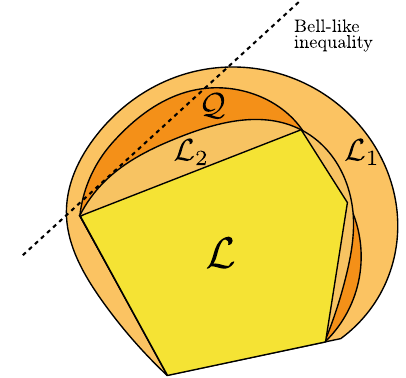
FIG. 1. Pictorial representation of the sets of correlations, together with our approach to detection of multipartite non- locality. The L and Q sets delimit the local and quantum correlations, respectively. As shown here, the first forms a polytope, namely, a convex set delimited by a finite amount of extremal points, while the second, despite still being convex, is not a polytope. The light orange sets are the first representatives of the hierarchy L 1 ⊇ L 2 ⊇ (cid:2) (cid:2) (cid:2) ⊇ L approximating the local set from outside. It can be seen that some of the quantum correlations lie outside the L 2 , meaning that they are detected as nonlocal from the SDP relaxation at the second level. The dotted line shows a Bell-like inequality that can be obtained by the corresponding dual